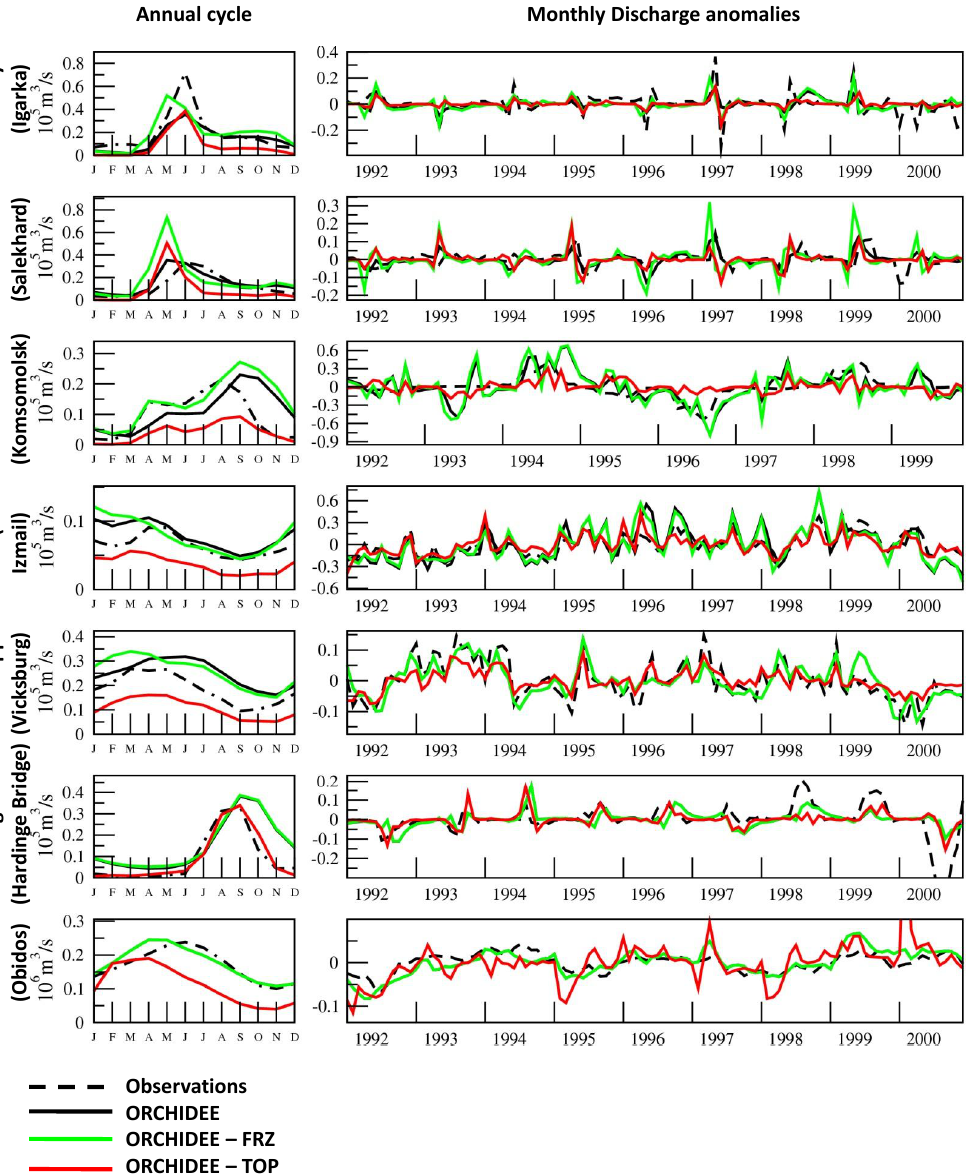
Fig. 3. Mean annual cycle (left) and time series of monthly anomalies (right) for simulated and observed discharges over the Yenisey, the Ob, the Amur, the Danube, the Mississippi, the Ganges and the Amazon. Simulated discharges are given for ORCHIDEE (black), ORCHIDEE- FRZ (green) and ORCHIDEE-TOP (red). Values of the skill score for each simulation using the different criteria are reported into Table 2.